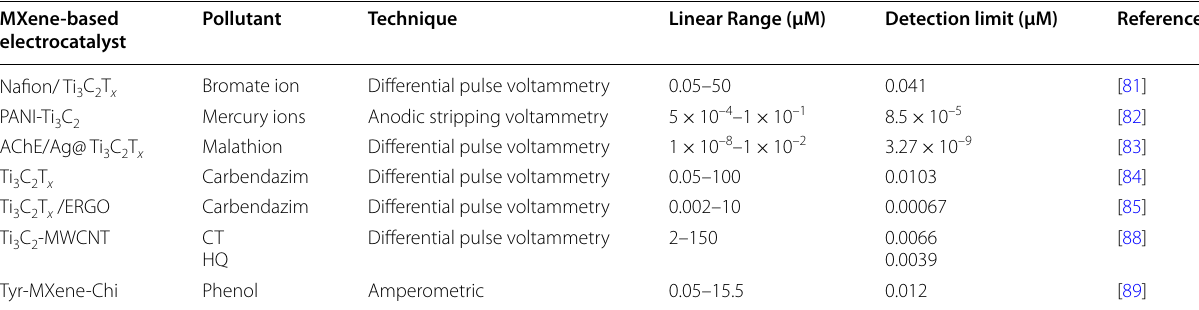
AChE acetylcholinesterase, ERGO electrochemically reduced graphene oxide, CT catechol, HQ hydroquino